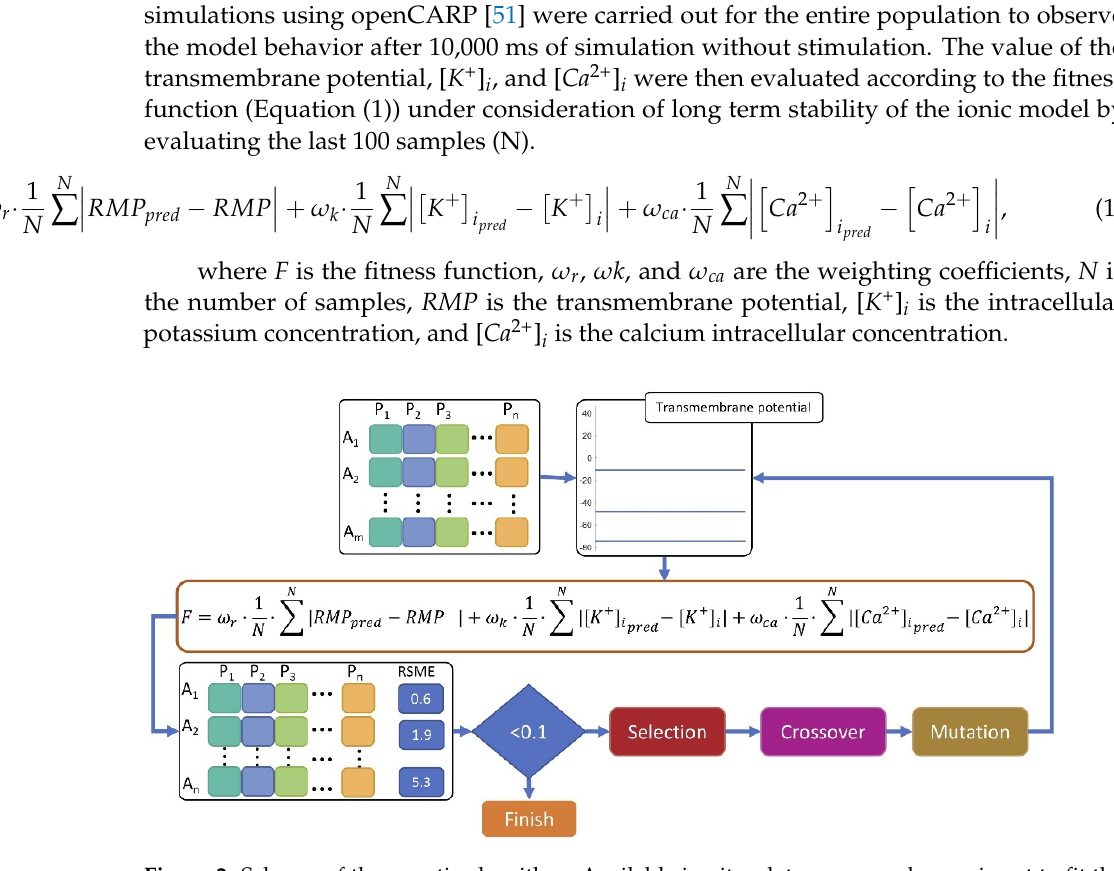
Figure 2. Scheme of the genetic algorithm. Available in vitro data were used as an input to fit the model parameters. The population is comprised of individuals ( A 1 to A m ) with different parameter values representing the “genes” ( P 1 to P n , n =11). After the transmembrane potential was simulated for all individuals, the fitness function (F) was evaluated. If the error was less than 0.1, the algorithm terminated. Otherwise, it continued by selecting the fittest individuals and allowing crossover and mutation of the genes to generate the next generation population. The process continued until the convergence condition was met.